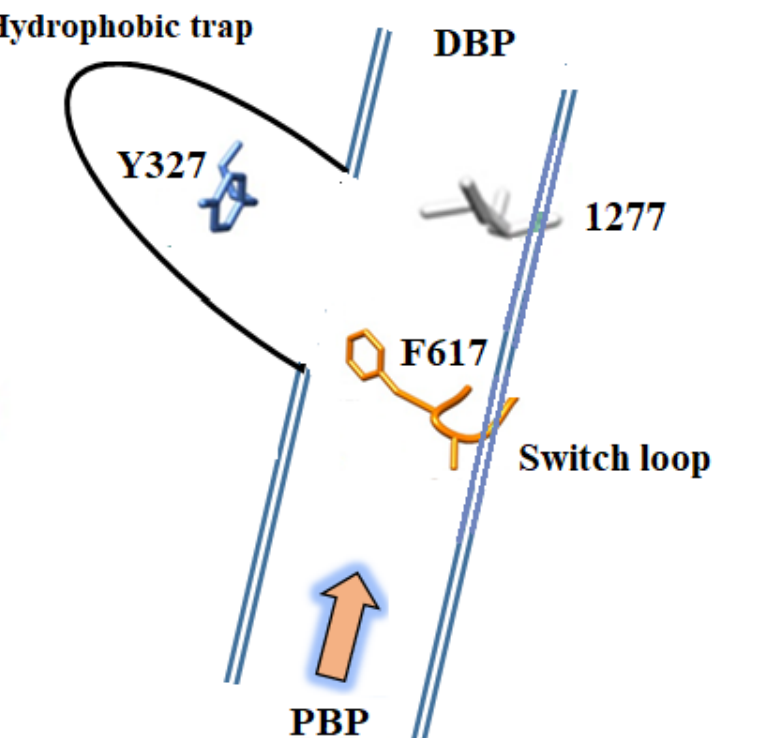
Figure 9. Schematic diagram showing the position of the hydrophobic trap relative to the proximal binding pocket (PBP) and the distal binding pocket (DBP). The switch loop that separates the PBP and DBP is shown in orange. Y327 which lies deep in the trap is highlighted, as is I277, which resides in the translocation tunnel. The yellow arrow depicts the direction substrates move through AcrB.